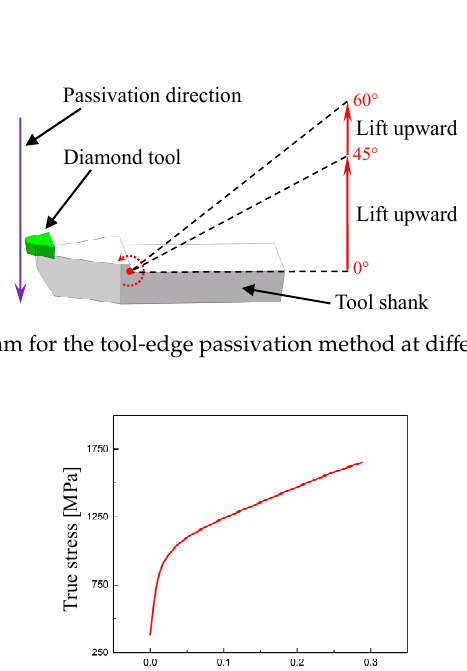
Figure 6. The curve of true stress vs. true strain for KDP crystal in SPH simulations [46].